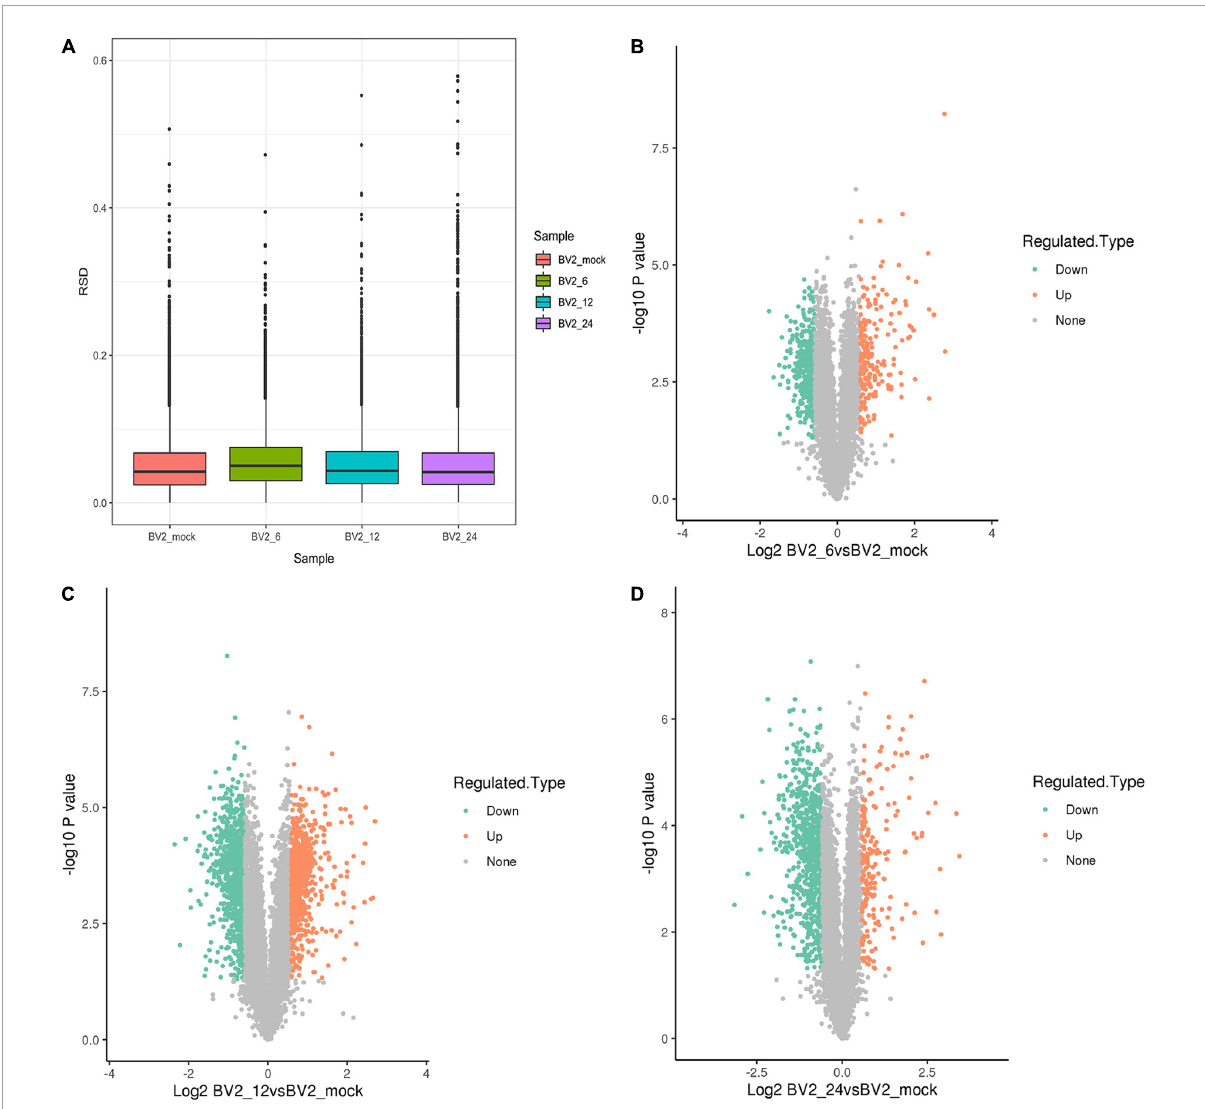
FIGURE1 (A) Boxplots illustrating relative standard deviation (RSD) of protein quantification results across replicates, with lower overall RSD values indicating higher quantitative reproducibility. (B) 212 upregulated DEPs at 6 hpi. (C) 754 upregulated DEPs at 12 hpi. (D) 191 upregulated DEPs at 24 hpi.